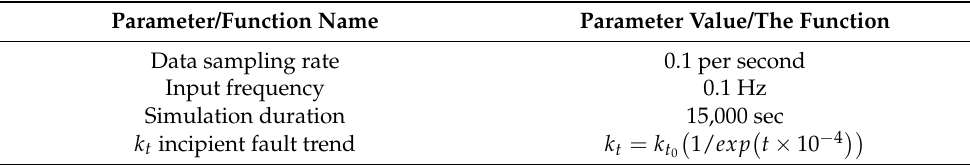
Table 8. Parameters for hours span simulation.